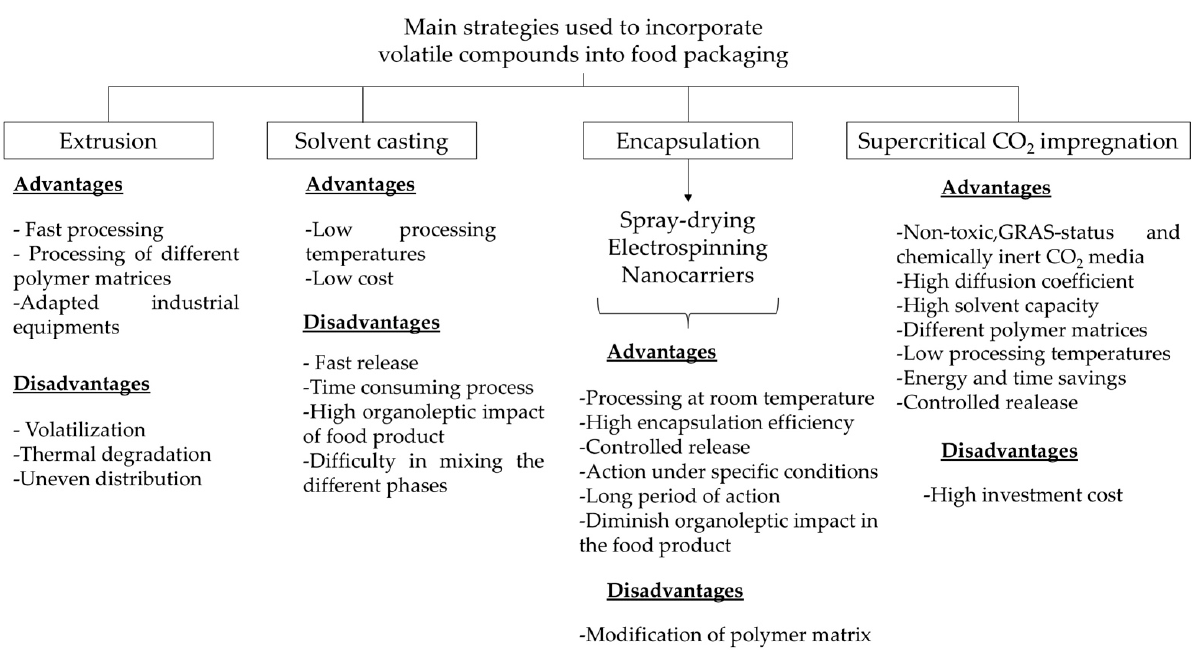
Figure 2. Scheme of advantages and disadvantages of main strategies used to incorporate volatile compounds into food packaging.